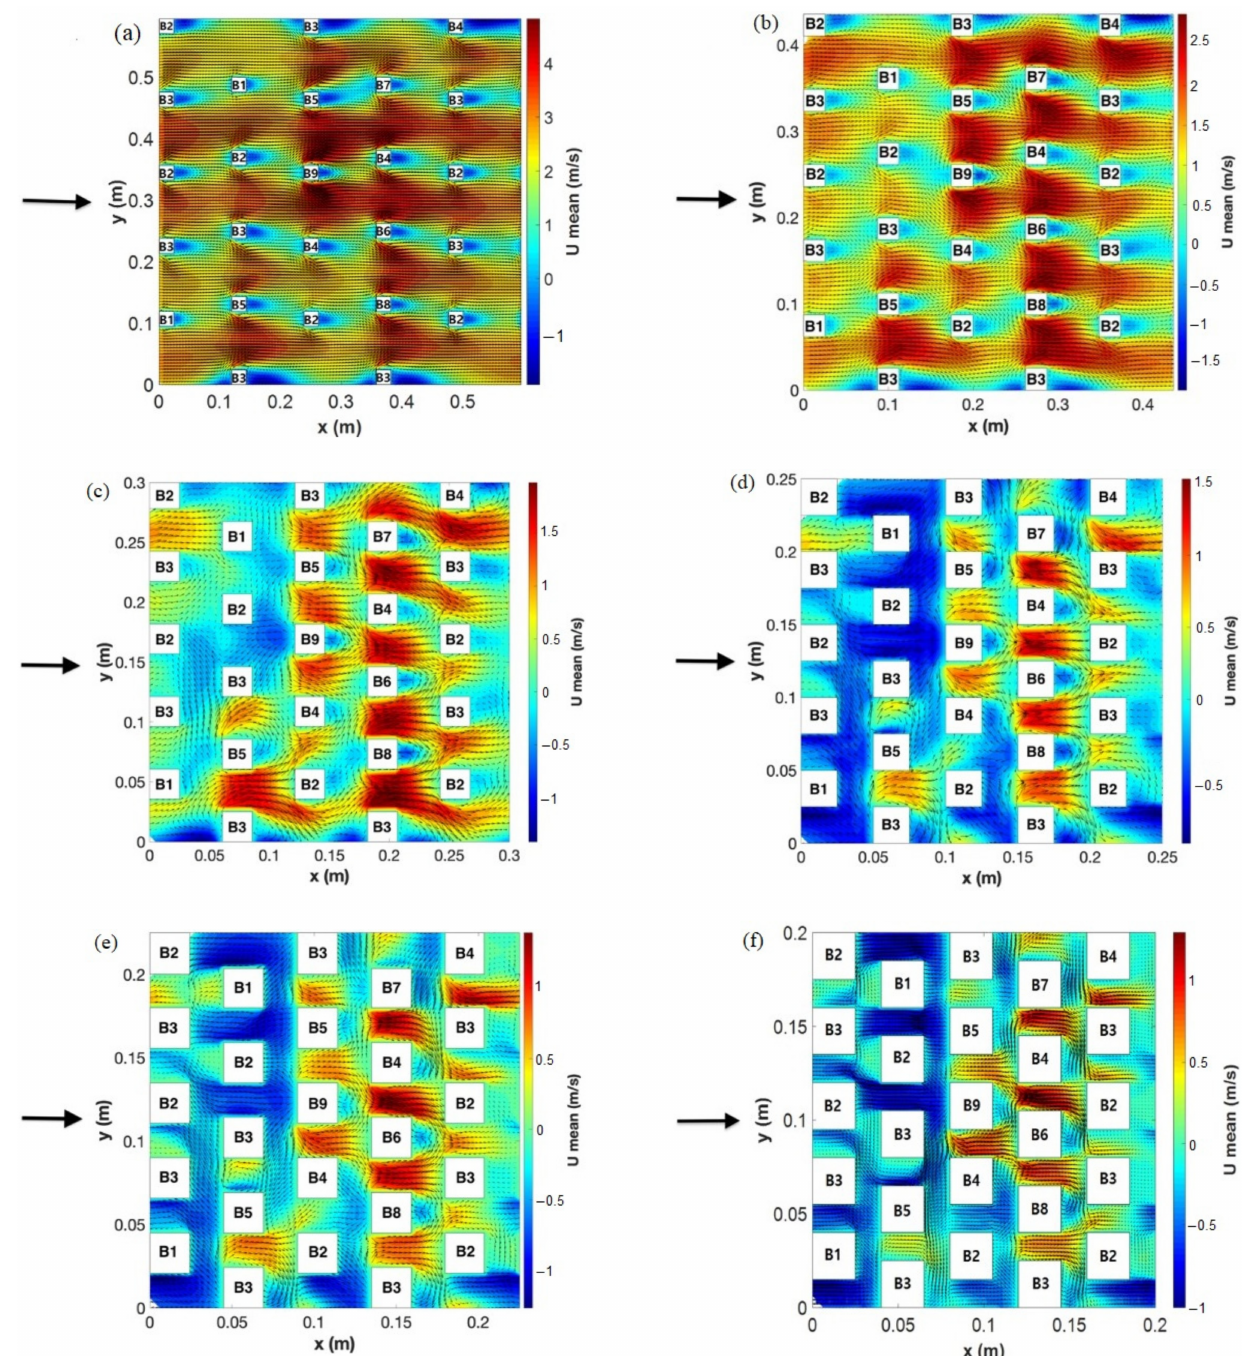
Figure 4. Mean wind velocity distribution on the horizontal plane at the pedestrian level for ( a ) R4A ( λ p = 0.04), ( b ) R8A ( λ p = 0.08), ( c ) R17A ( λ p = 0.17), ( d ) R25A ( λ p = 0.25), ( e ) R31A ( λ p = 0.31), and ( f ) R39A ( λ p = 0.39). The arrow indicates the wind direction and the labels for building types (i.e., B1 to B9 ) are displayed for all